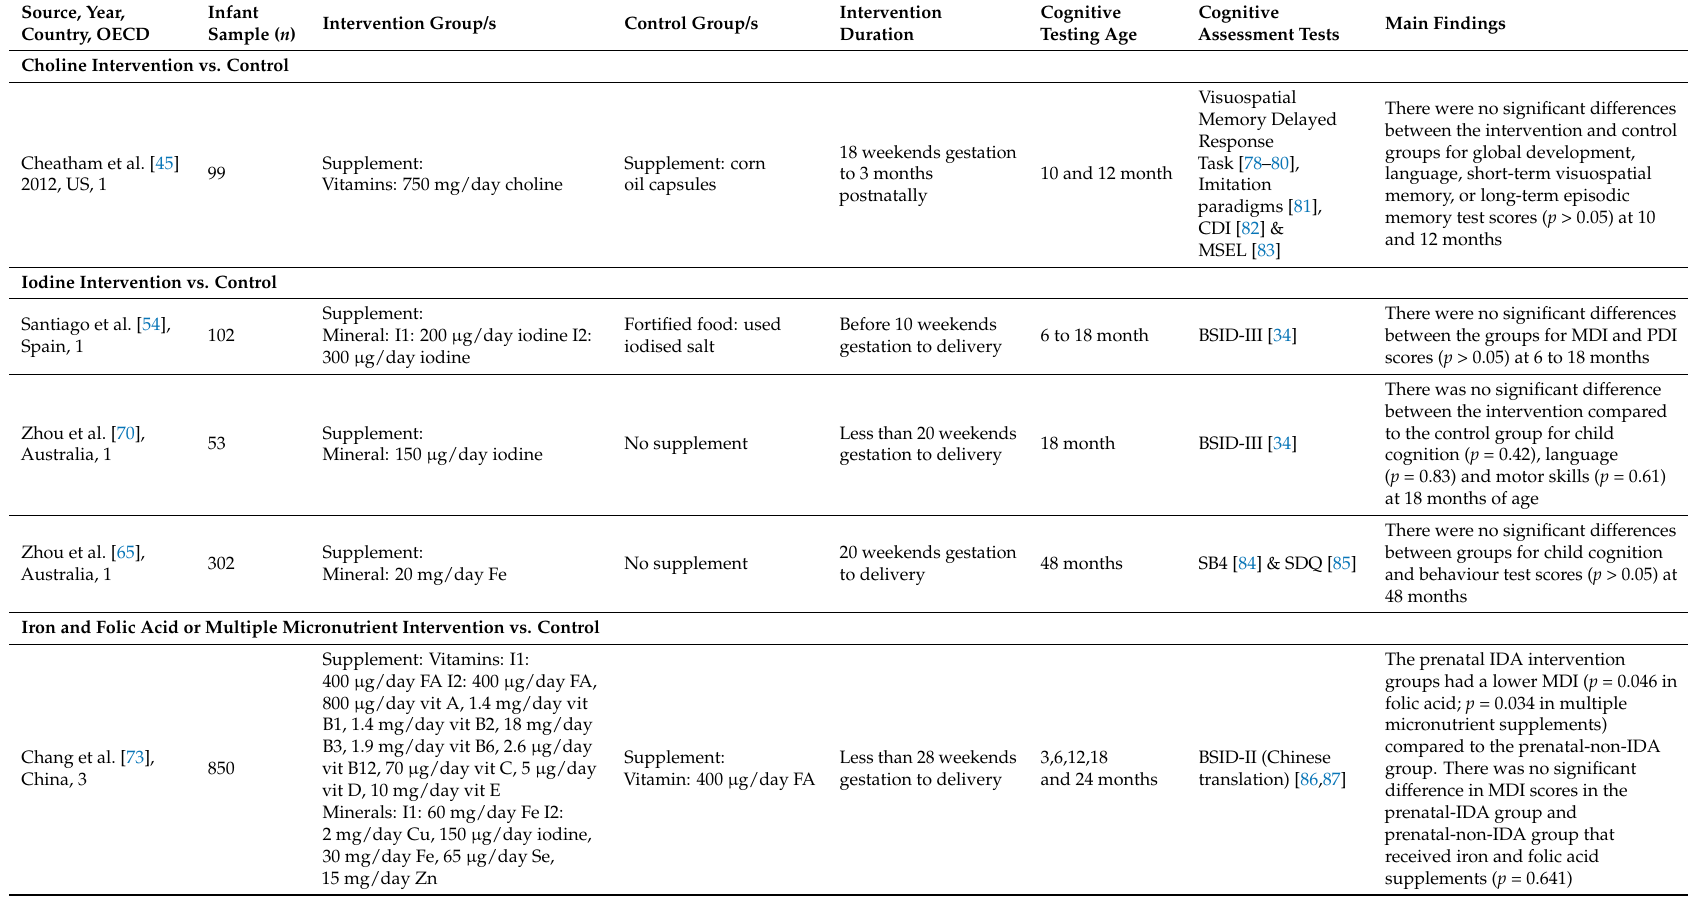
Table 2. Overview of the characteristics of the randomised controlled trials